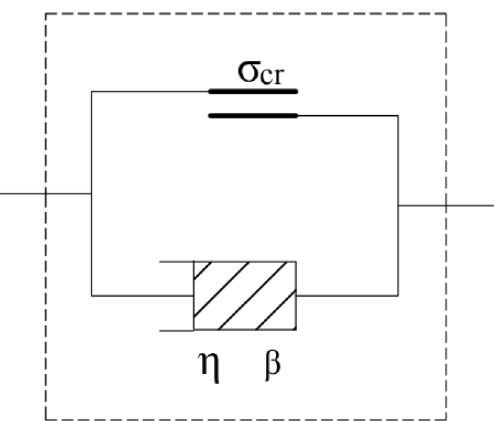
Figure 9. Nonlinear viscoplastic body model considering